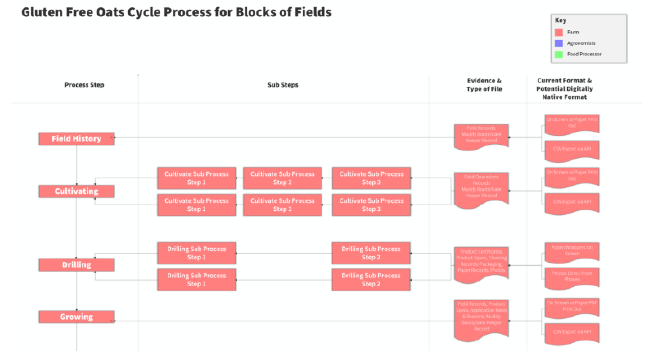
Figure 1: The process mapping of steps and data required as proof in the gluten-free oats cycle.